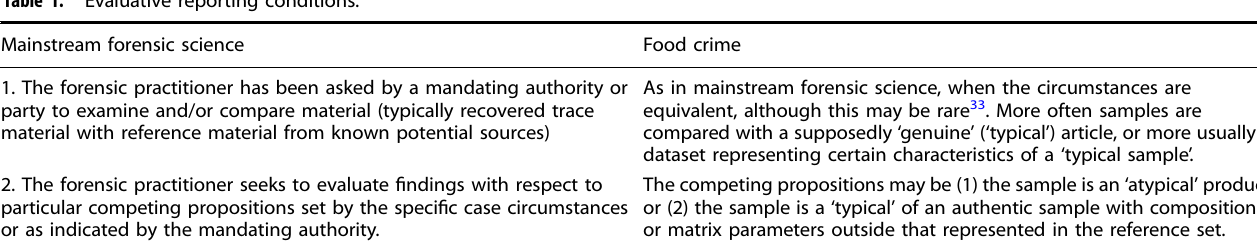
Table 1. Evaluative reporting